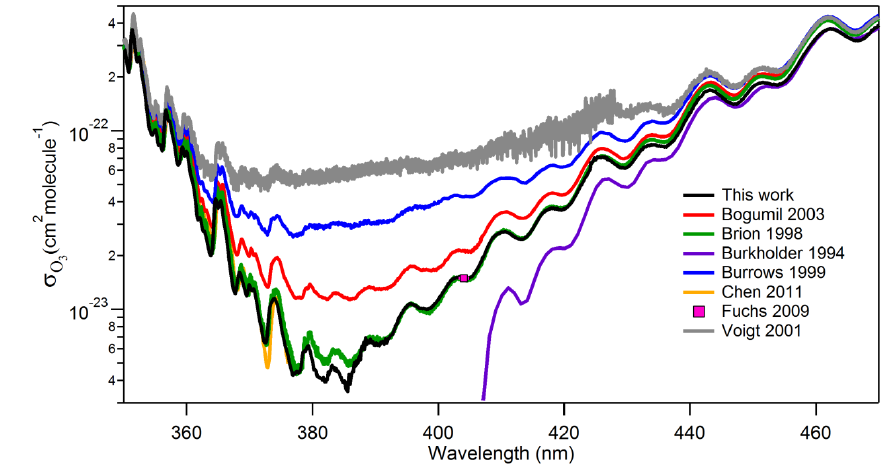
Fig. 4. The O 3 cross section from 350–470nm determined in this work compared to other published Figure 4. The O 3 cross section from 350 – 470 nm determined in this work compared to other 612 published measurements. 613